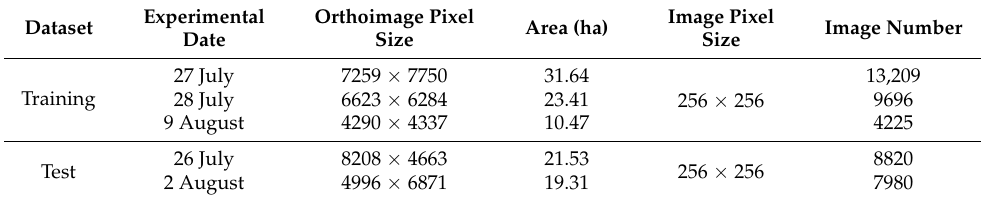
Figure 5. Sample images of cropping ground truth and orthoimage images into 256 × 256 pixels. ( a ) Training dataset and ( b ) test dataset. Table 1. Details of training and test